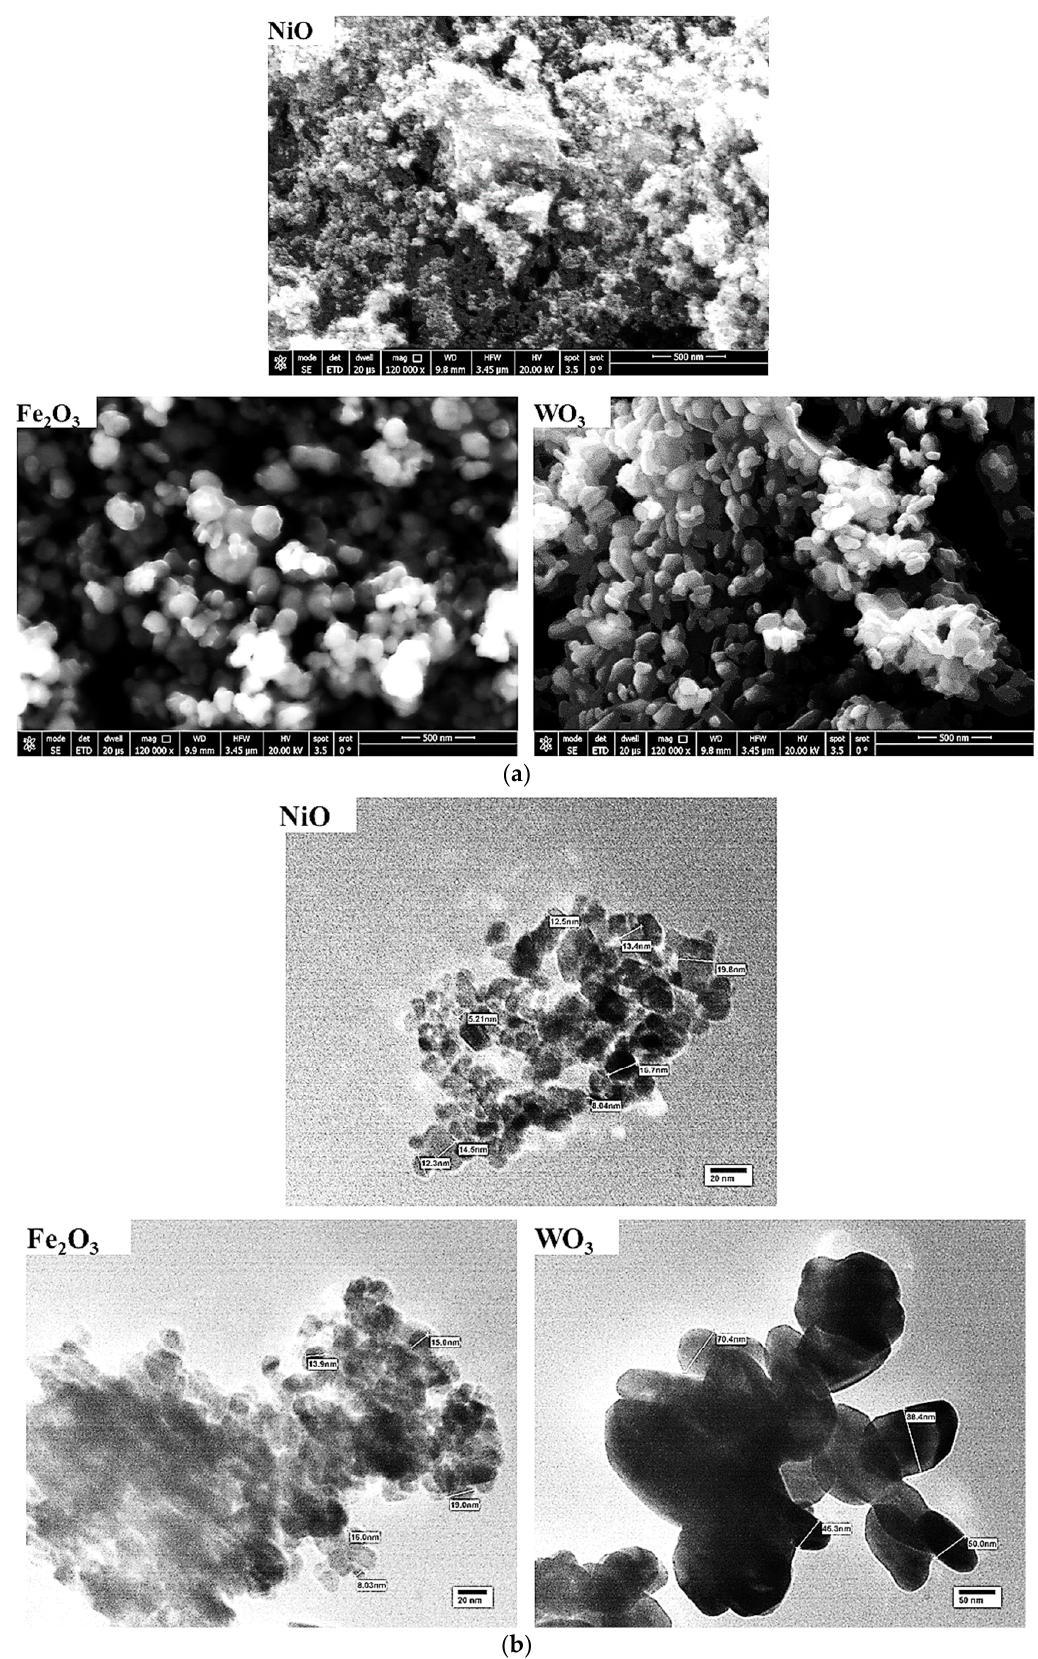
Figure 2. SEM ( a ) and TEM ( b ) images of nanosized metal oxides.